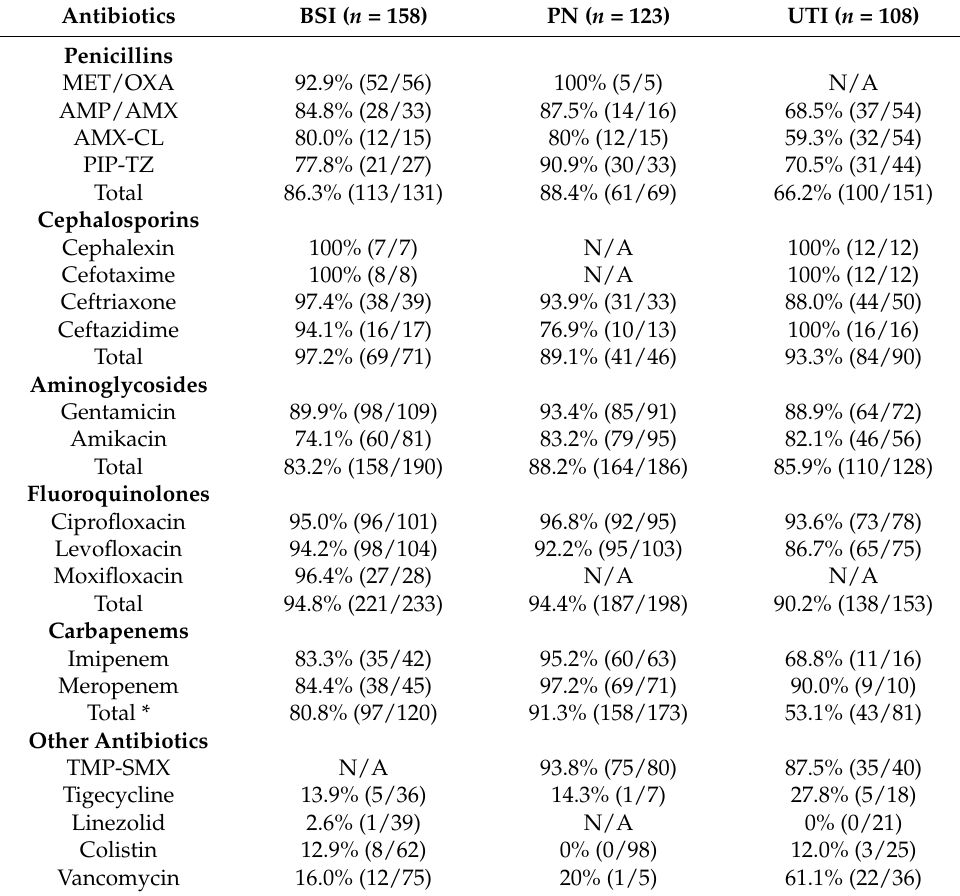
Table 7. Four-year antimicrobial resistance rates of BSIs, PNs, and UTIs in our